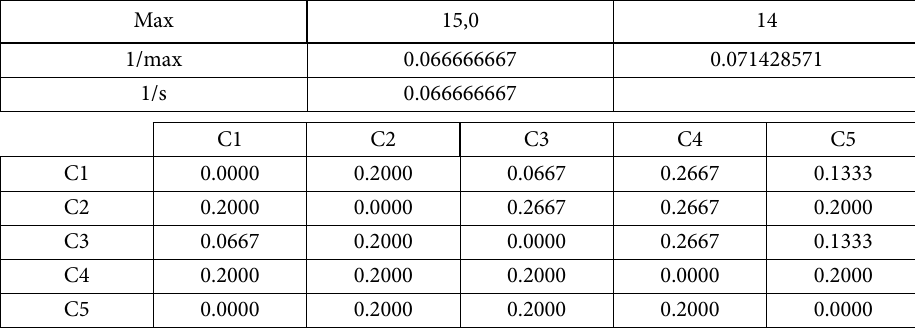
Table 8. Normalized direct influence matrix X for inter-cluster